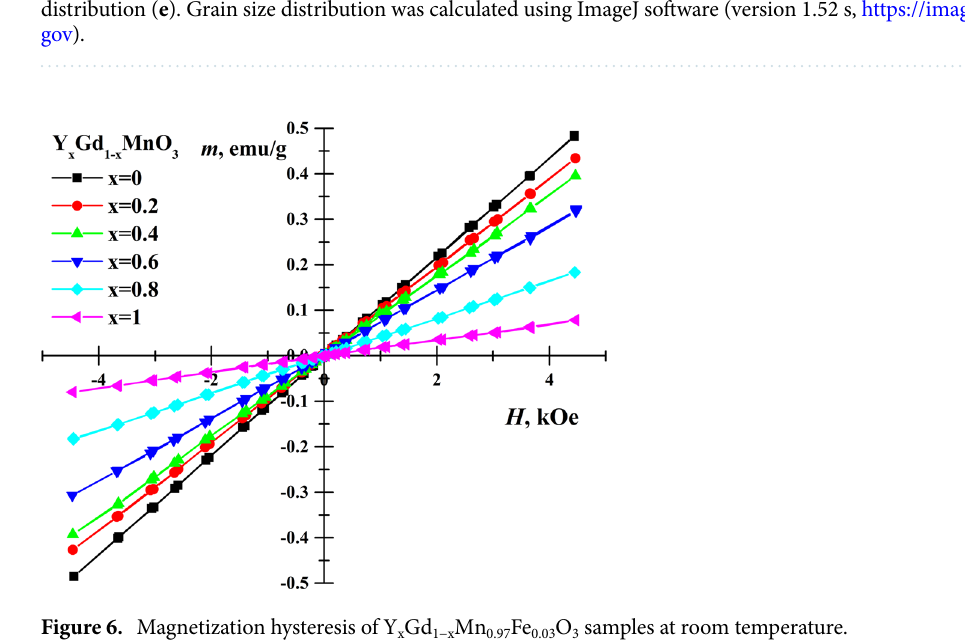
Figure 6. Magnetization hysteresis of Y x Gd 1−x Mn 0.97 Fe 0.03 O 3 samples at room